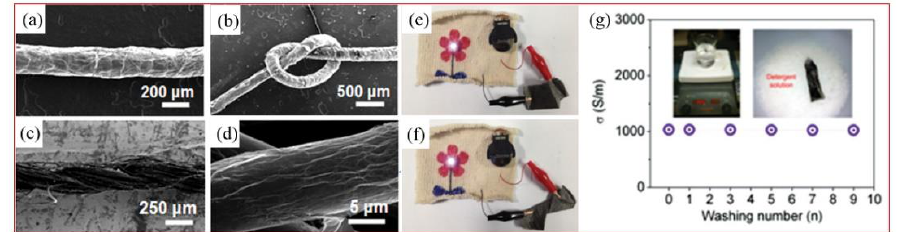
Figure 4. SEM images of ( a ) rGO-coated nylon fiber, ( b ) knotted rGO-coated nylon fiber, ( c ) rGO- coated commercial PES yarn, and ( d ) wrinkles on the surface of PED yarn. Stability in conducting behavior for ( e ) bending and ( f ) twisting. ( g ) Stability in conductivity for washing with detergent. Reprinted with permission from Reference [29]. Copyright (2013) John Wiley and Sons.